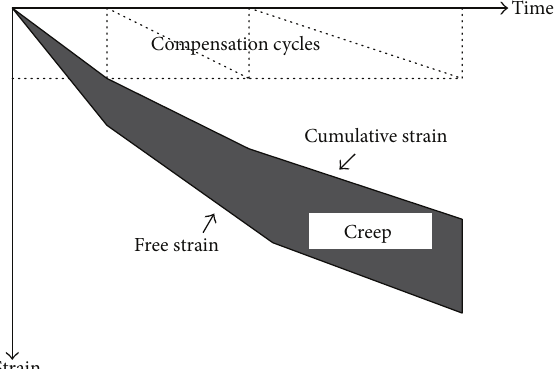
Figure 10: Creep strain calculation method [5].